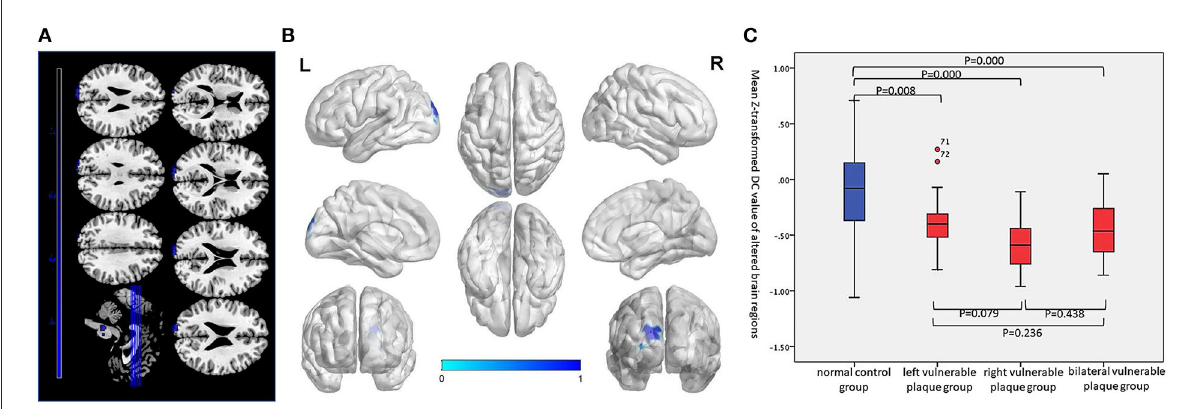
FIGURE2 (A,B) Compared with the normal control group, the asymptomatic vulnerable plaque group showed decreased DC in the SOG.L (cluster size 70, p < 0.05, FWE correction). (C) Brain regions with abnormal DC values were extracted for multiple comparisons among the normal control group, left asymptomatic vulnerable plaque group, right asymptomatic vulnerable plaque group, and bilateral asymptomatic vulnerable plaque group. Compared with the normal control group, the left, right, and bilateral vulnerable plaque groups showed significant differences; however, the DC in this area did not significantly differ among the left, right, and bilateral groups.